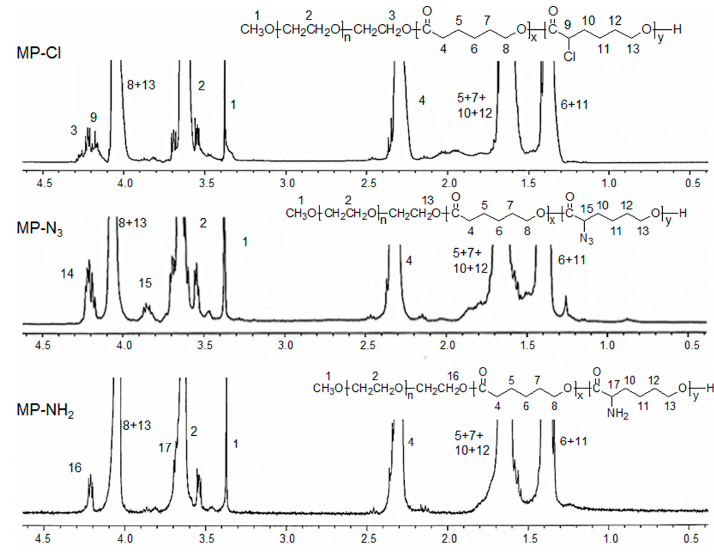
1 H-NMR spectra of MP-Cl, MP-N